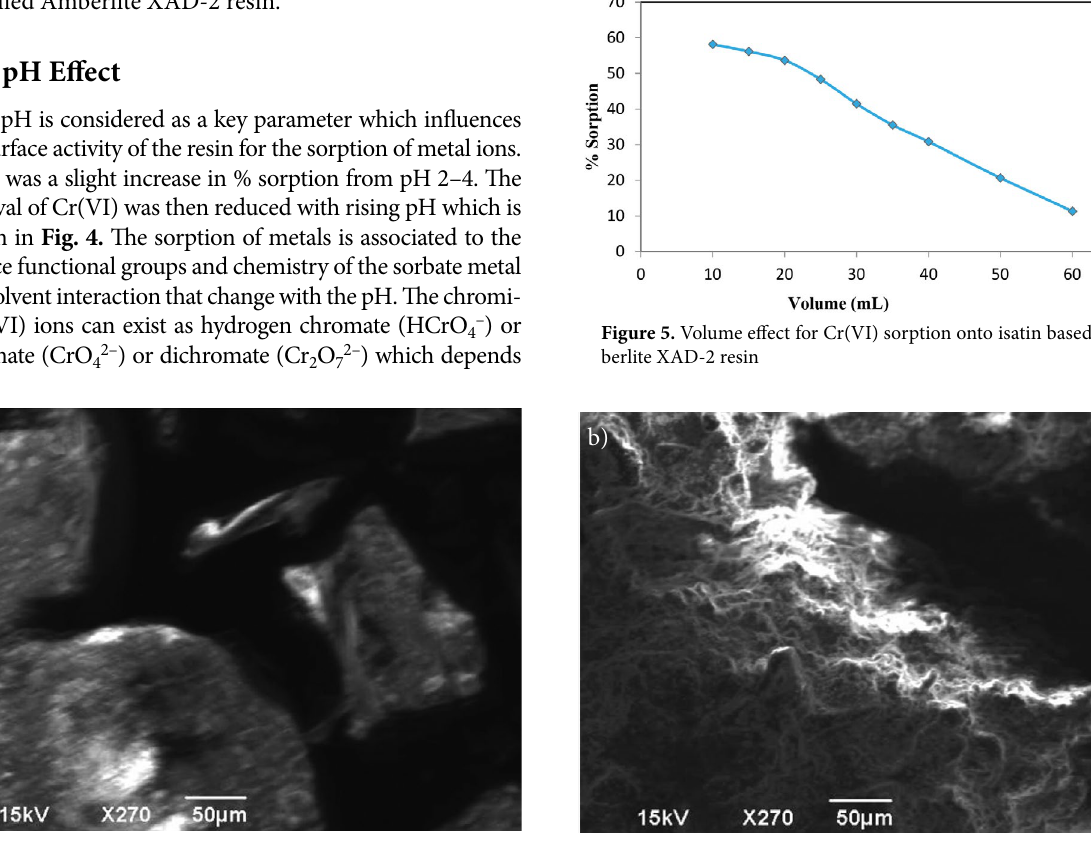
Figure 3. SEM photograph of (a) free Amberlite XAD-2, (b) Isatin based Amberlite XAD-2